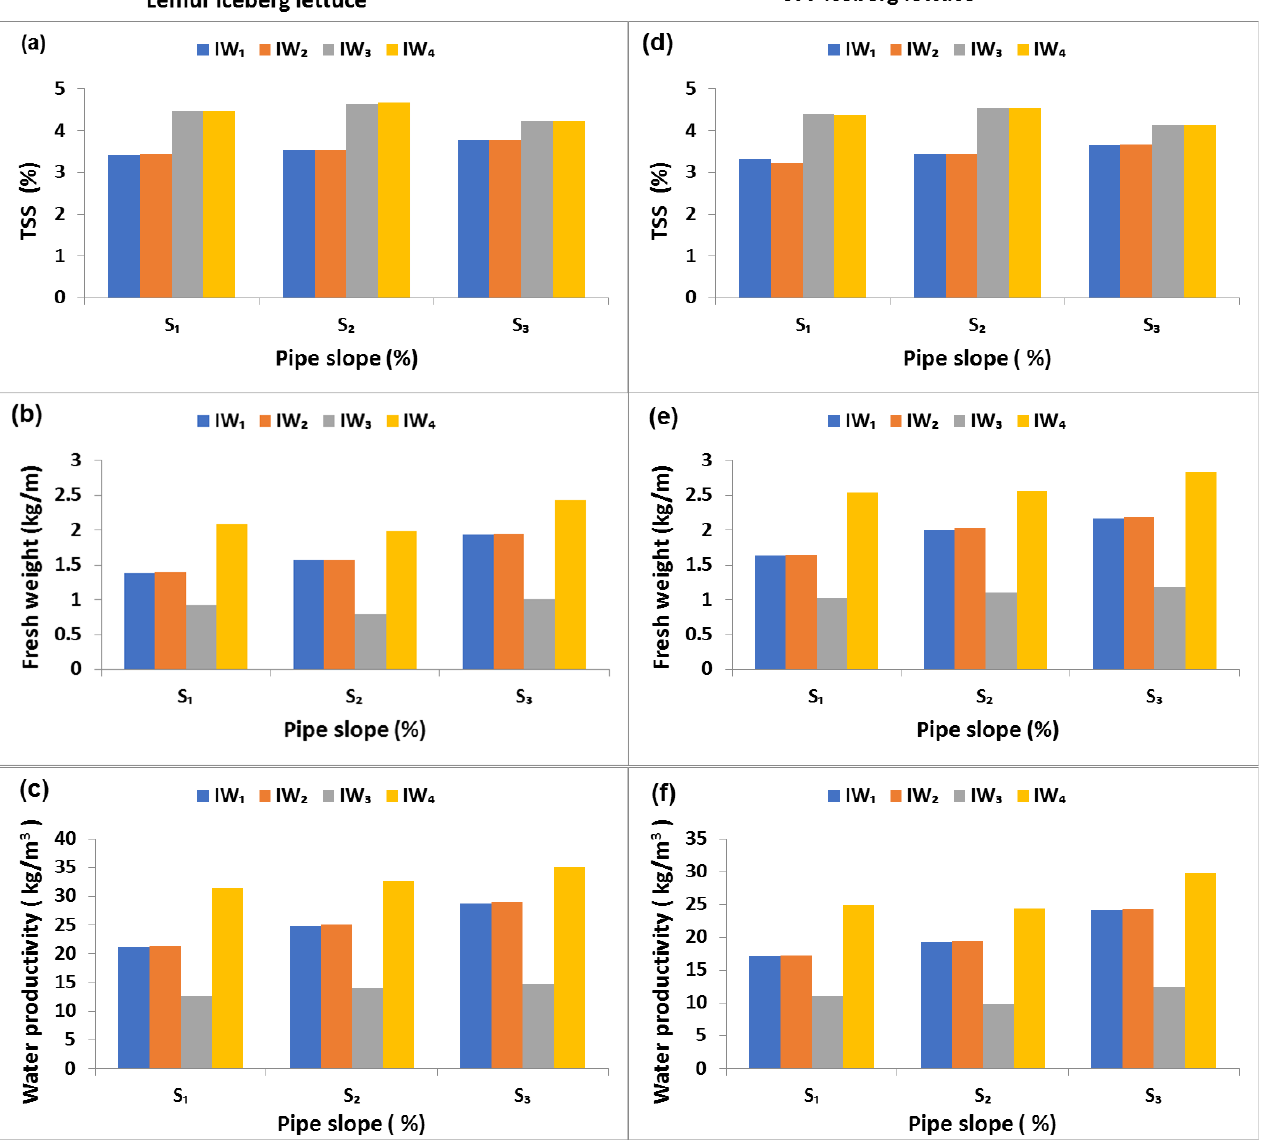
Figure 2. Interaction between irrigation water type and pipe slope on ( a , d ) total soluble solids (TSS), ( b , e ) fresh weight and ( c , f ) water productivity for lemur iceberg lettuce and 077 iceberg lettuce, respectively. IW 1 refers to common irrigation water, IW 2 represents magnetically treated common irrigation water, IW 3 represents saline water and IW 4 represents magnetically treated saline water. S 1 , S 2 , and S 3 refer to pipe slope at 0.000%, 0.025% and 0.075%, respectively.